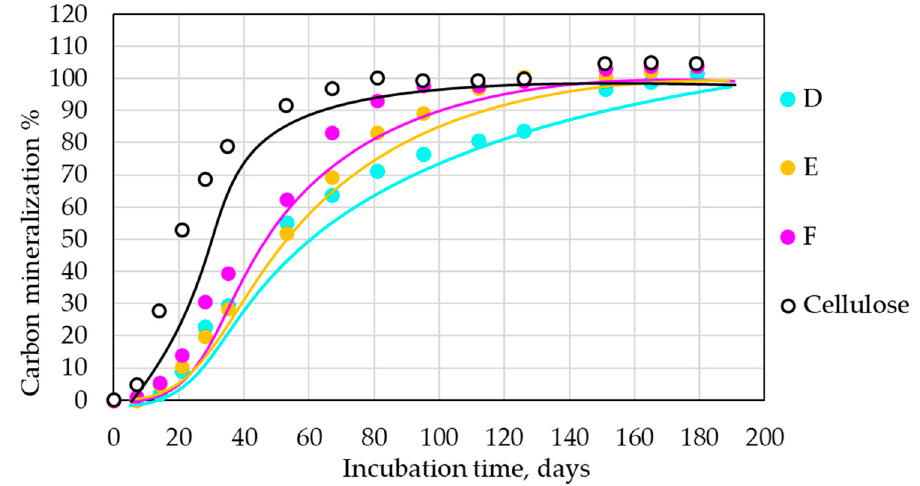
Figure 4. Mineralization of samples under home-composting conditions, 28 °C. Three samples for each composition were measured, including the reference sample (cellulose). All samples exhibited total mineralization in a period of about 180 days. The average standard deviation for all tested compositions was ±3.9 for the home-composting conditions. An about 15-day-long lag phase occurred for all tested samples. Additionally, the curves for the tested samples were not so far from that of the cellulose reference and had the expected order. The thin film of the PLA/PHB/TPS blend (F) exhibited the fastest biodegradability, followed with a minimal gap by the thin film sample without TPS (E).